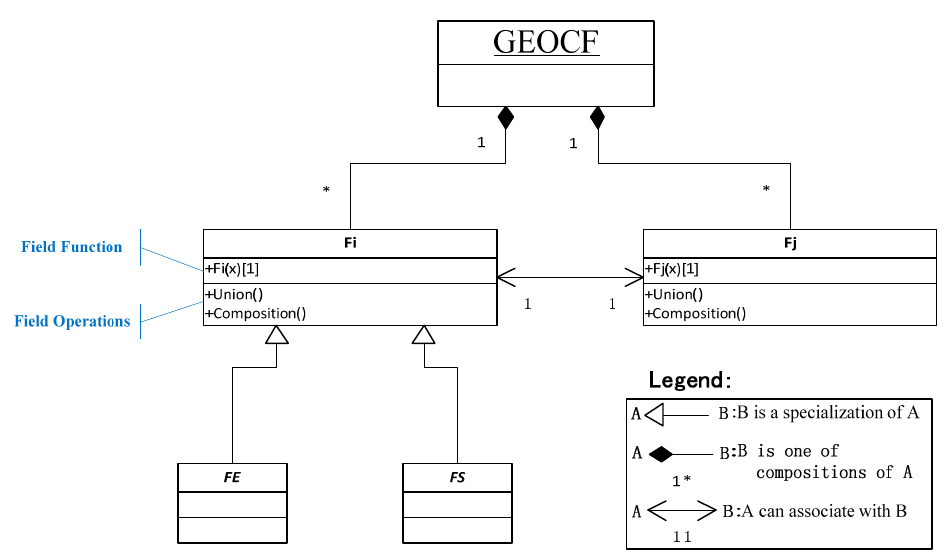
Figure 2. The framework of the GEOCF (Blue font represents the corresponding instructions).